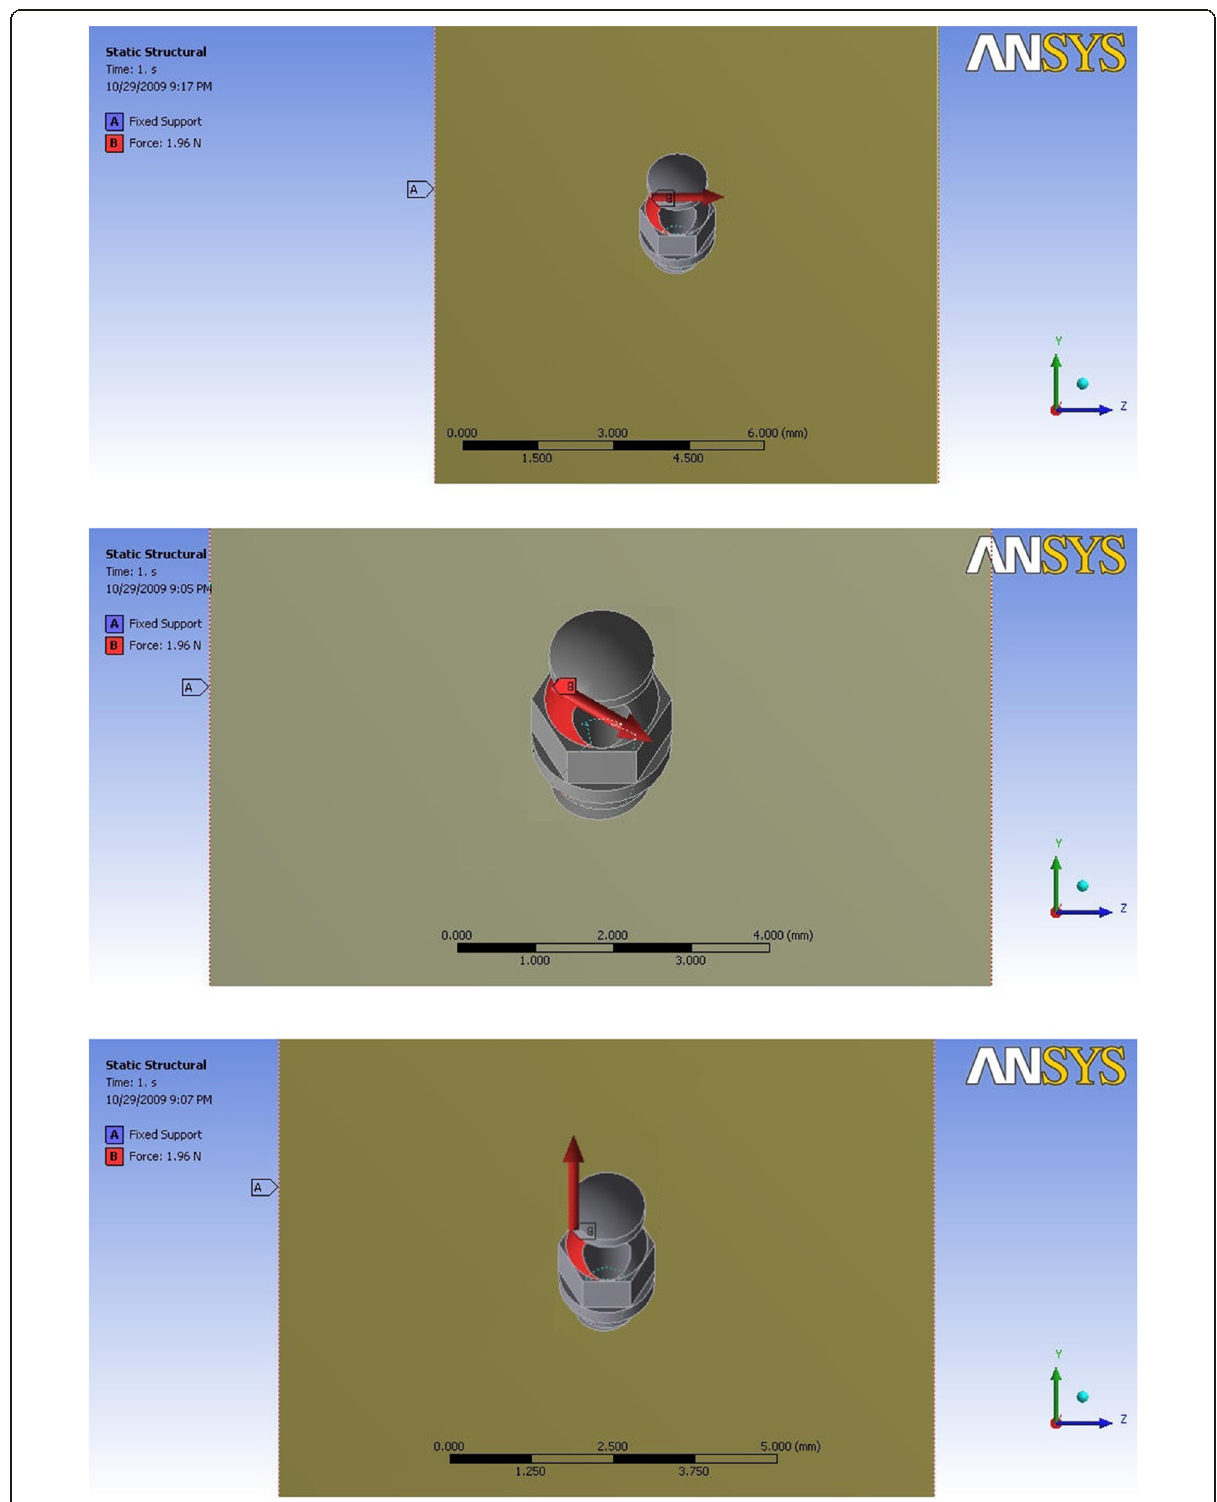
Fig. 2 Direction of orthodontic force to head of mini-implant: force applied at 90° to vertical plane (simulating anterior retraction), 30° to vertical plane (simulating anterior intrusion and retraction), and 90° to horizontal plane (simulating molar